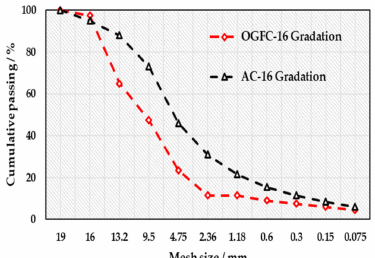
Figure 3. Gradation of asphalt concrete (AC)-16 and OGFC-16 in the